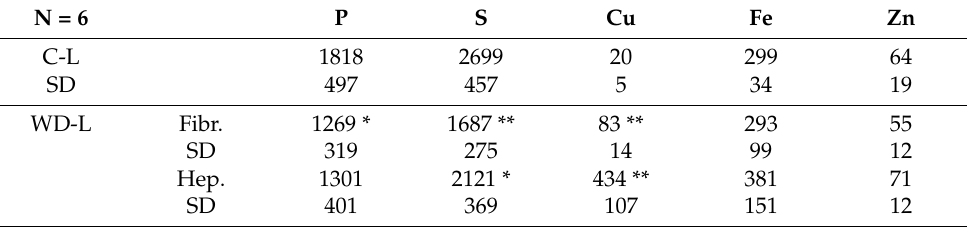
Table 4. Mean element concentrations in ppm ± SD in control liver (C-L) and WD-L. For WD-L data were stratified into fibrotic areas (Fibr.) and hepatocytes (Hep.). Significant differences between C-L and WD-L, (fibrotic area and hepatocytes, respectively) are indicated by * for p < 0.05, or by ** for p <